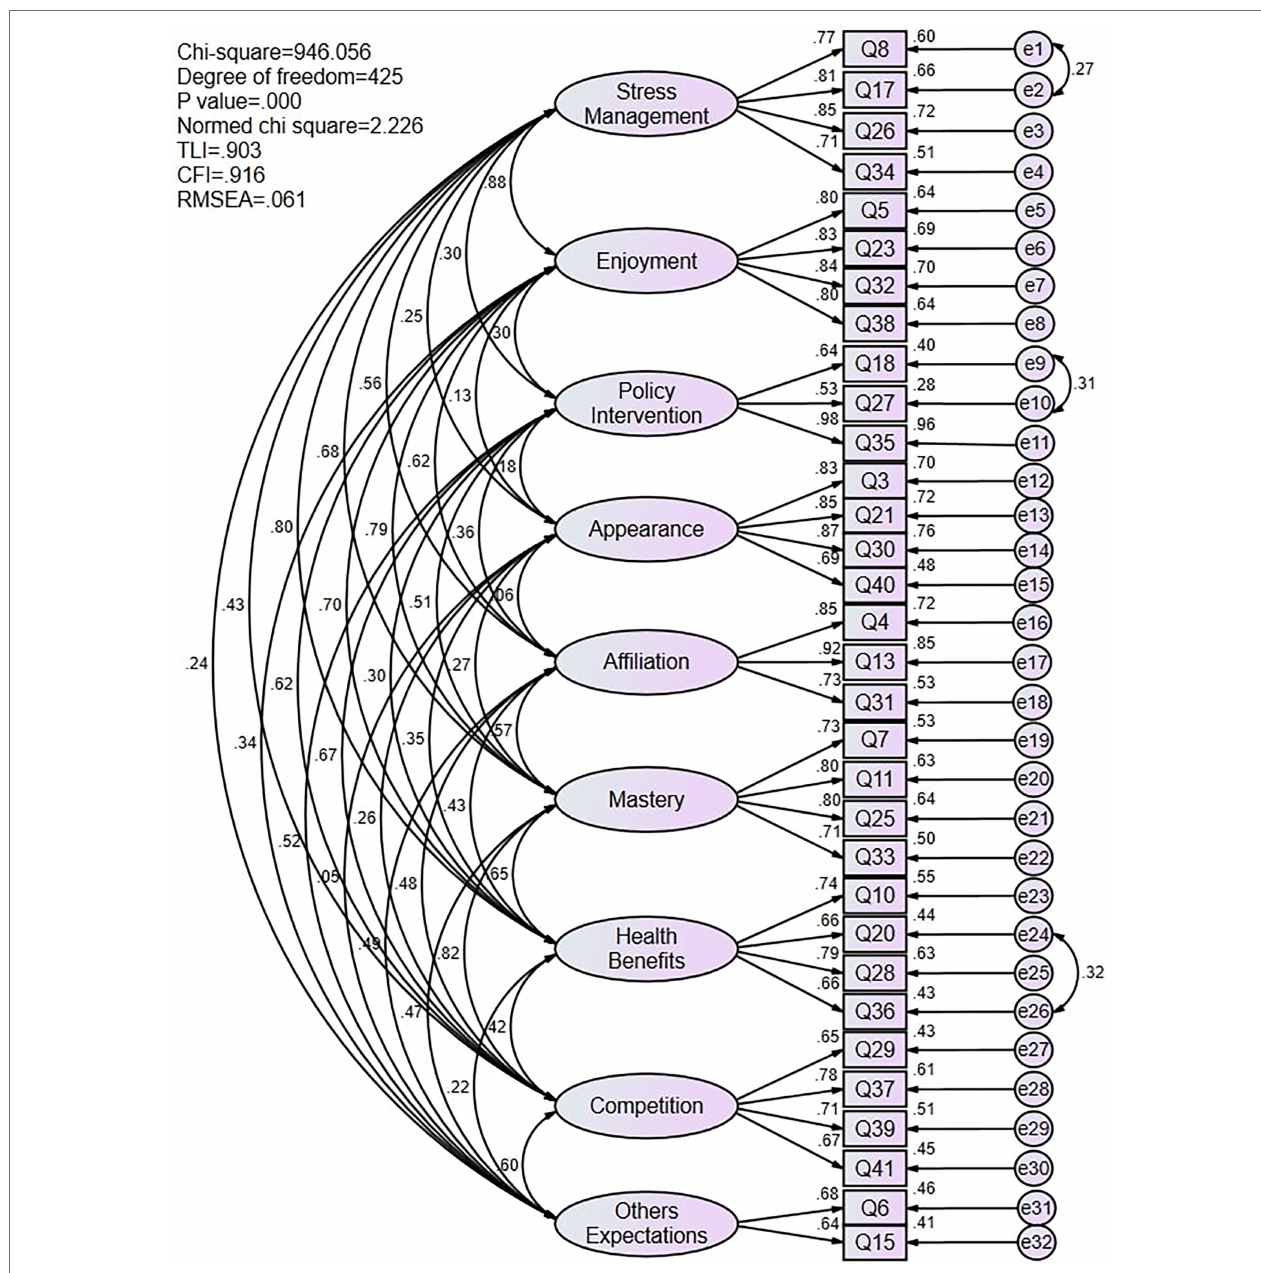
FIGURE 2 | Measurement model for